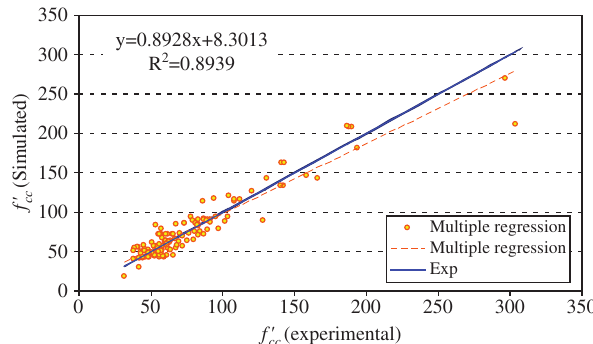
Figure 12 Predictions of the best MR model against experimental data.